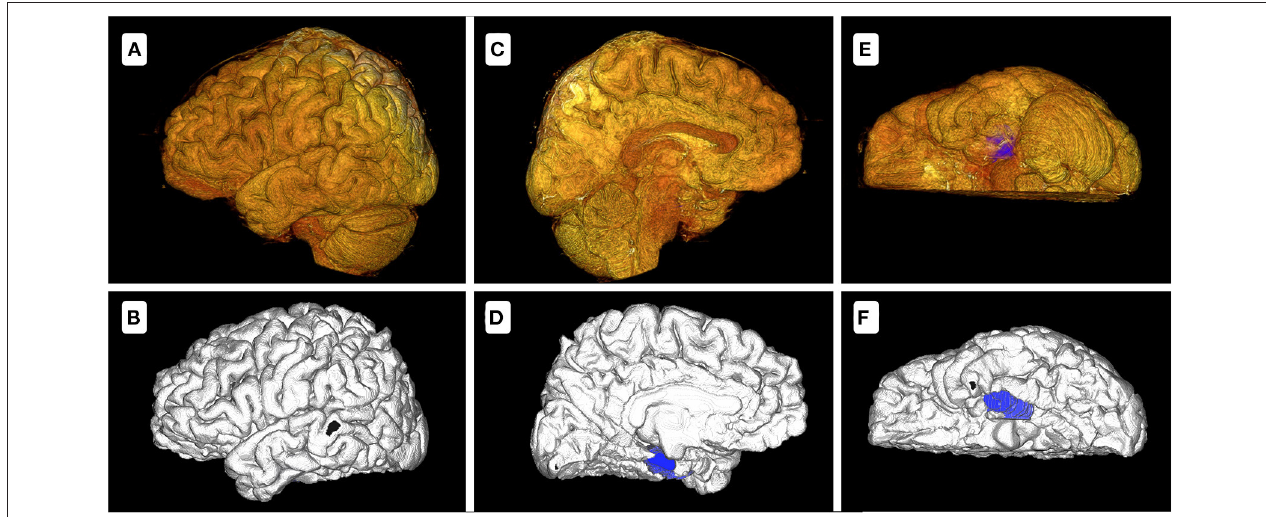
FIGURE 2 | Model comparison between methods 1 and 2 of patient 6 with a lesion on the left medial temporal lobe. (A,C,E) show the cerebral-hemisphere and lesion models designed with method 1. (B,D,F) show the cerebral-hemisphere and lesion models designed with method 2. There are apparent differences between the two methods. In method 1, the sulci and gyri of the medial and inferior sides are unclear, with the blocking of cerebellum and brainstem, while method 2 does not exhibit these problems. In (D,F) , the blue demarcations represent the lesion model. In (C) , the lesion model is entirely blocked by the cerebellar hemisphere and brainstem. In (E) , the lesion model is partially